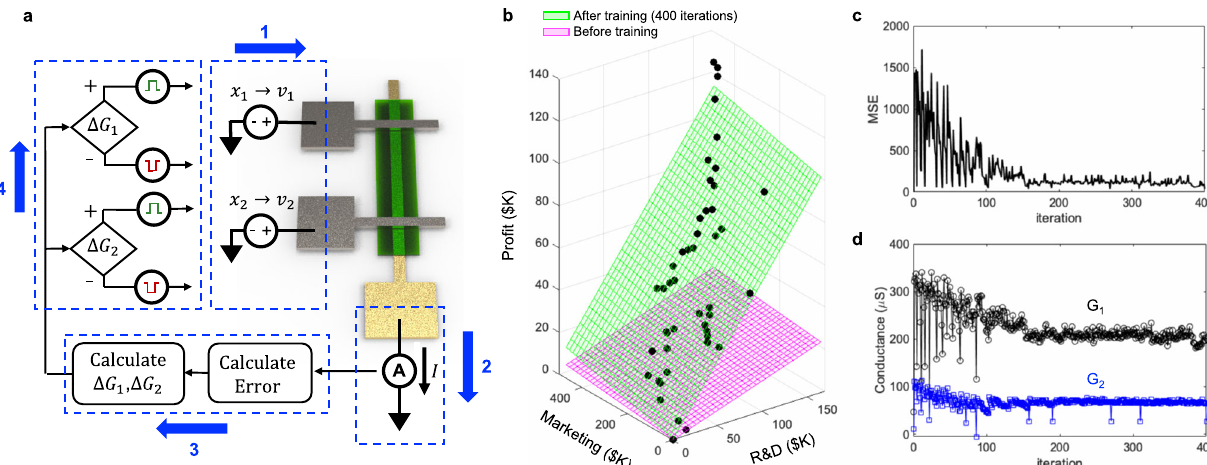
Fig. 5 Implementation of stochastic multivariable linear regression on h-BN memristor arrays. a Flow diagram for stochastic multivariable linear regression on h-BN memristor arrays (graphical description of one step in the training process): In step 1, the inputs (independent variables) are translated to DC voltages and applied to the array (top electrodes). In step 2, the total output current (the model prediction) is measured at the shared bottom electrode. In step 3, the prediction error is calculated by comparing against the training sample, and model parameter updates are obtained ( Δ G 1 and Δ G 2 ). In step 4, a single programming pulse is applied to each memristor (polarity of the pulse determined by the sign of Δ G ). Good convergence of the implementation is veri fi ed by b model prediction fi t to training data before (magenta plane) and after (green plane) training. c Evolution of mean squared error (MSE) with training, and d evolution of h-BN memristor conductances (model parameters) with training step (iterations) reaching stable values that minimize prediction